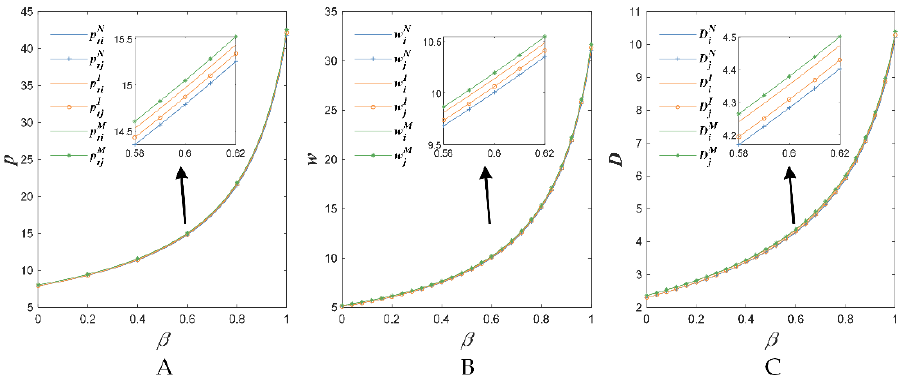
Figure 4. The sensitivity to the price of competitive agricultural products’ impact on retail price ( A ), wholesale price ( B ) and demand ( C ).